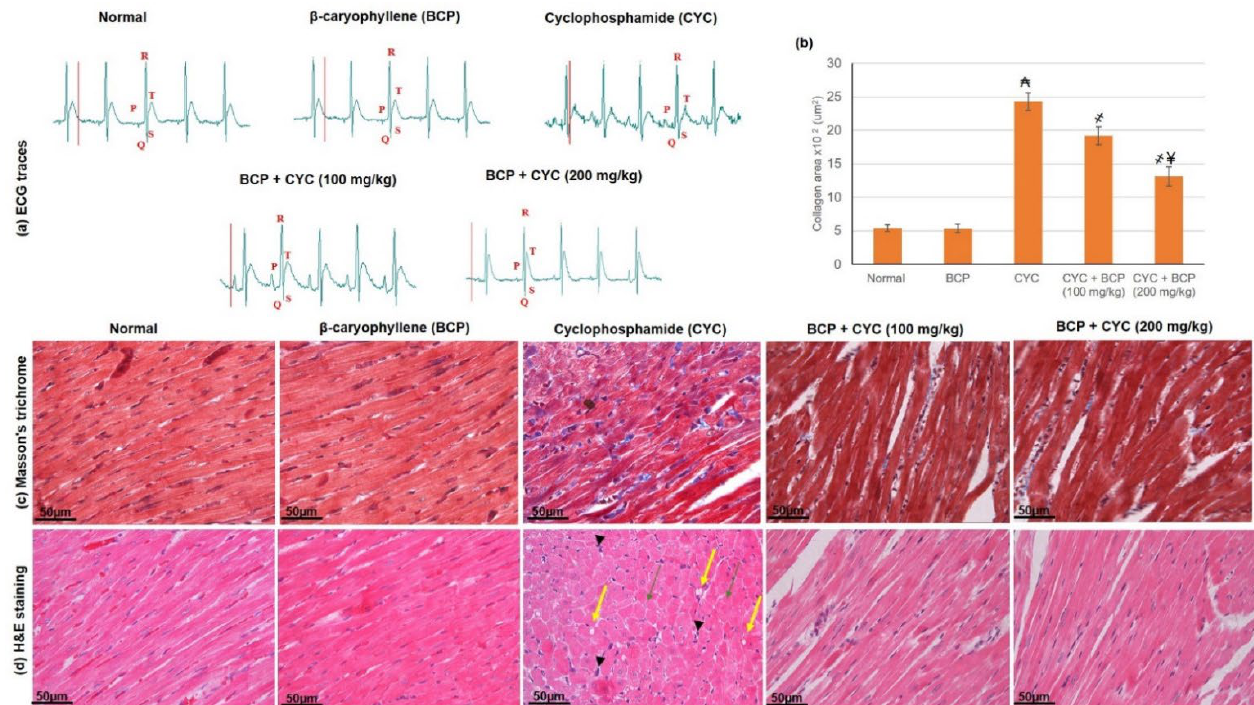
Figure 1. Effects of treatment with β -caryophyllene (BCP) for 14 days on cyclophosphamide (CYC) induced cardiac injury on ( a ) ECG traces, ( b ) Quantification of collagen area from Masson trichrome stained sections and on heart sections stained with ( c ) Masson’s trichrome, ( d ) H&E in rats. All values are expressed as mean ± SD. ₳ indicates a statistically significant difference from normal group;